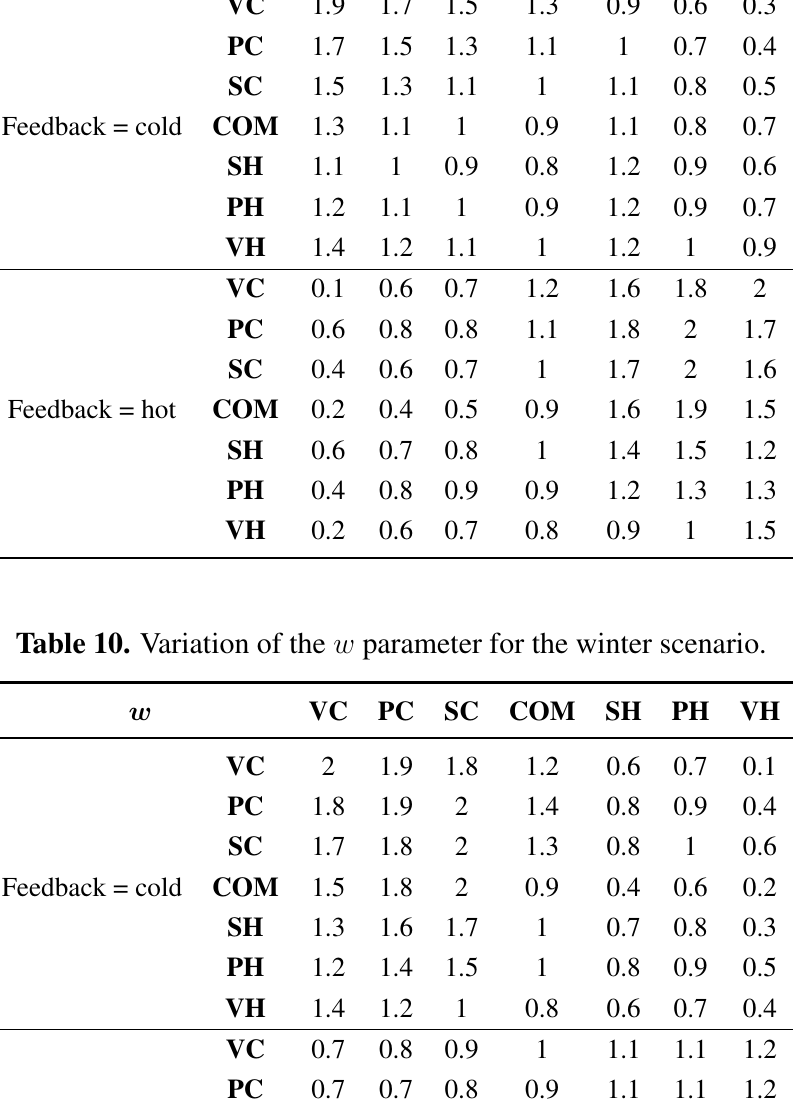
Table 9. Variation of the w parameter for the summer scenario. w